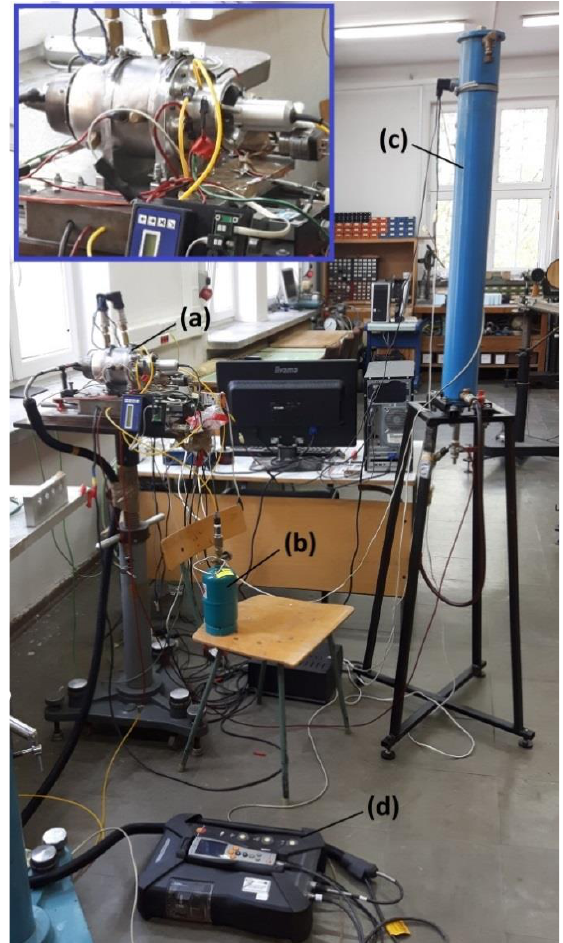
Figure 1. GTM-120 gas turbine test stand: ( a ) GTM-120 gas turbine; ( b ) gas fuel tank; ( c ) liquide fuel tank; ( d ) exhaust gas analyzer. Table 1. Parameters of the sensors used to measure the emissions.